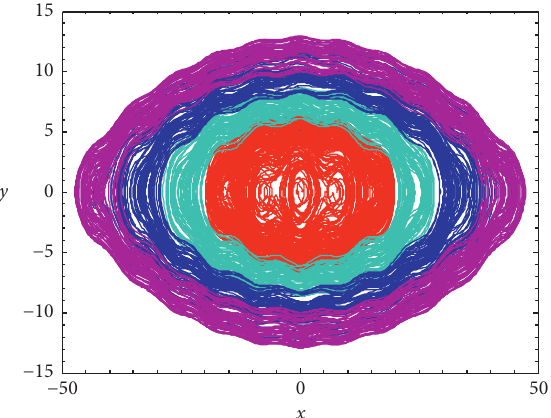
Figure 4: Trajectories showing different coexisting strange attractors of system (28) for A � 0 . 58. Each trajectory is for a duration of 1200 seconds.